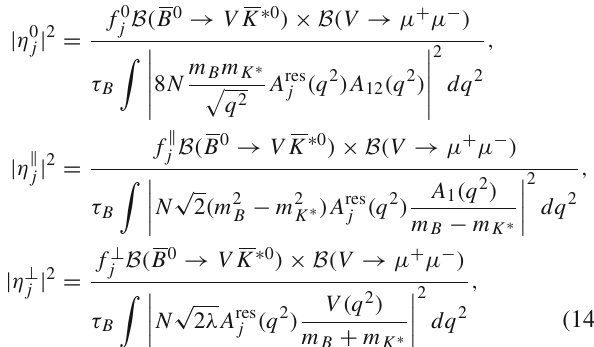
Fig. 7 Distributions of the CP -averaged observables in the SM as a function of q 2 below (left) and above (right) the open charm threshold (cyan). Specific choices are highlighted for θ 0